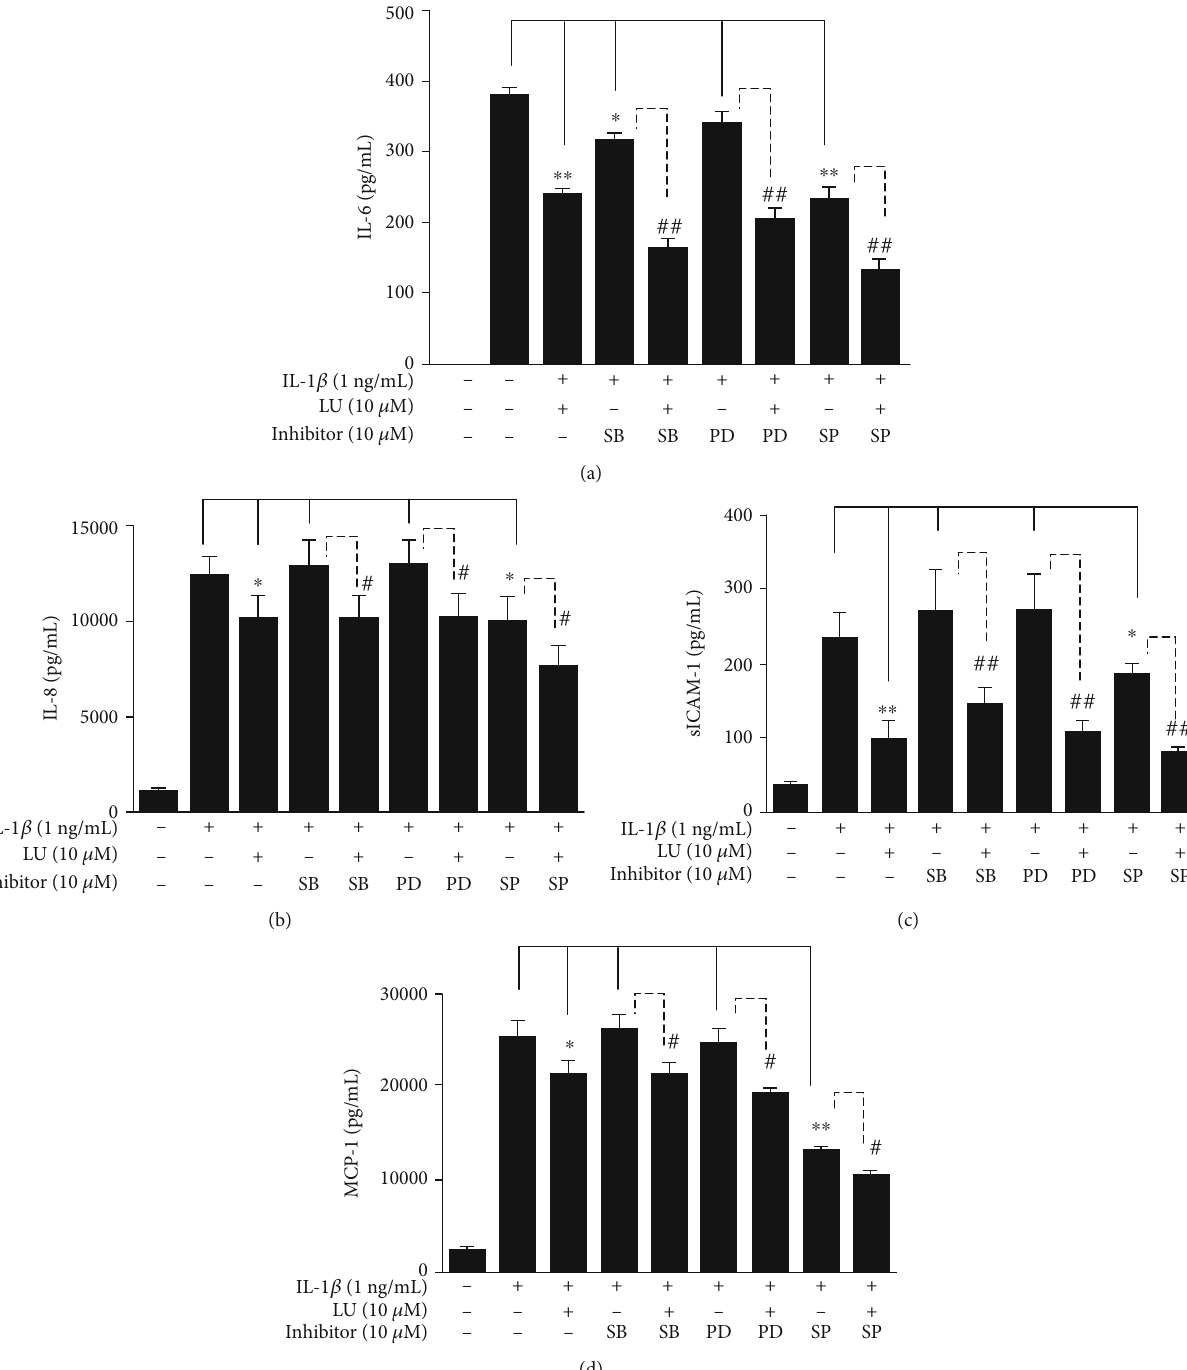
Figure 8: MAPK inhibitors mediated the expression levels of cytokines and chemokines in IL-1 β -stimulated ARPE-19 cells. ARPE-19 cells were treated with MAPK inhibitors (10 μ M SB203580 (SB), 10 μ M PD98059 (PD), or 10 μ M SP600125 (SP)) with or without 10 μ M luteolin and then incubated with IL-1 β for 24h. ELISA results showed the levels of (a) IL-6, (b) IL-8, (c) sICAM-1, and (d) MCP-1. Data represent the mean ± SD . ∗ p < 0 : 05 , ∗∗ p < 0 : 01 , compared to ARPE-19 cells stimulated with IL-1 β alone. # p < 0 : 05 , ## p < 0 : 01 , compared to IL-1 β - stimulated ARPE-19 cells pretreated with only MAPK